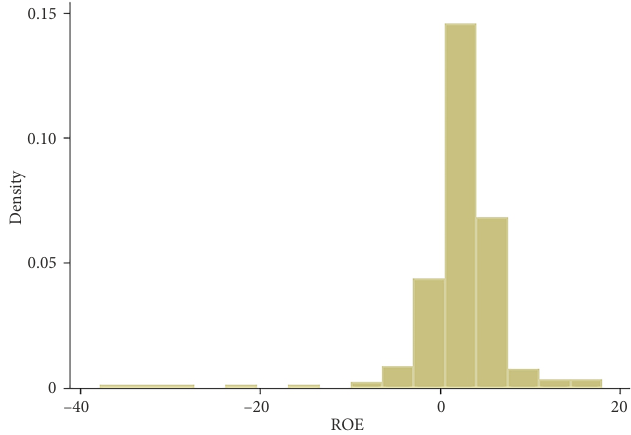
Figure 3. ROE histogram: IC-manufacturing